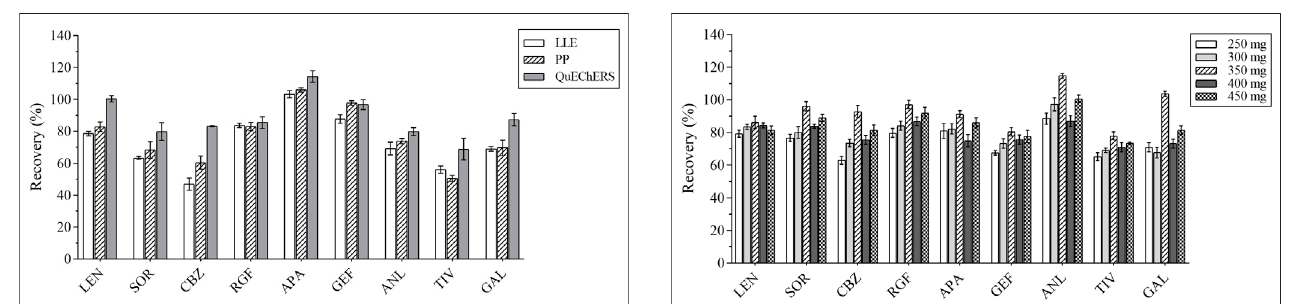
FIGURE 1 | The recovery results of all analytes by the 3 pretreatment methods.